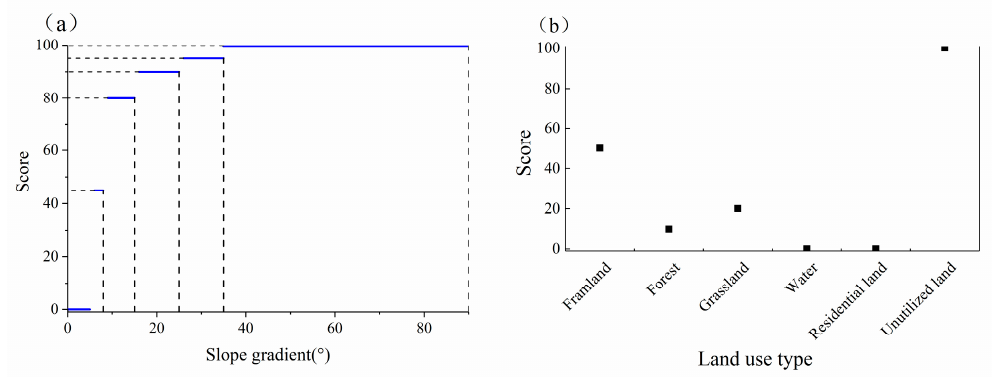
Figure 3. Examples of normalization applied in the case study. ( a ) Numerical variable normalization. ( b ) categorical variables normalization.